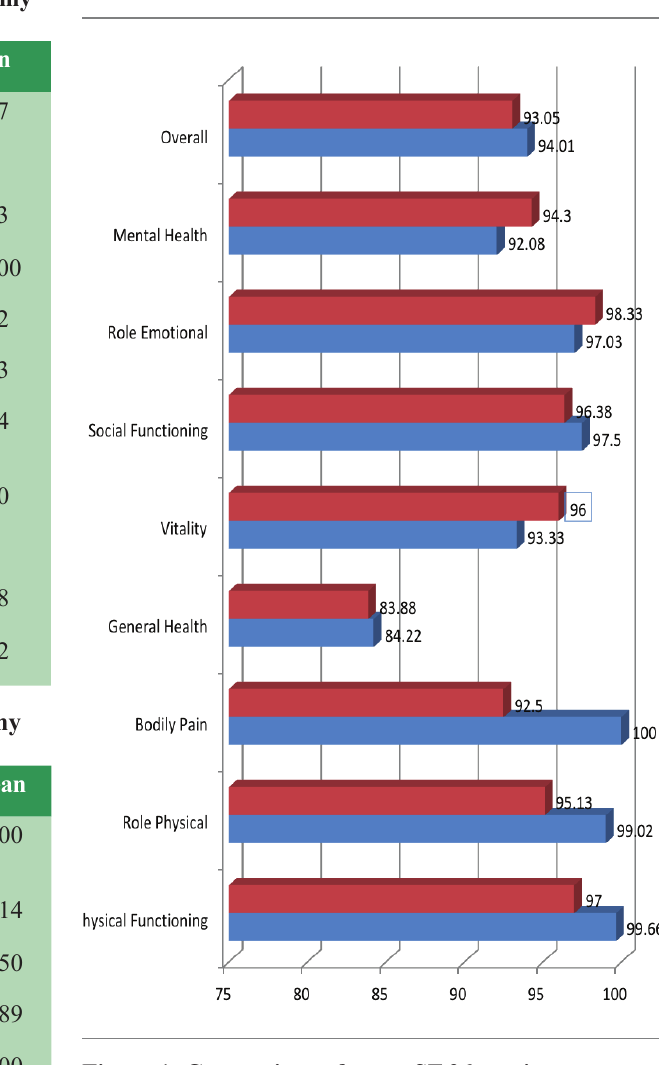
Figure 1: Comparison of mean SF 36 scoring on